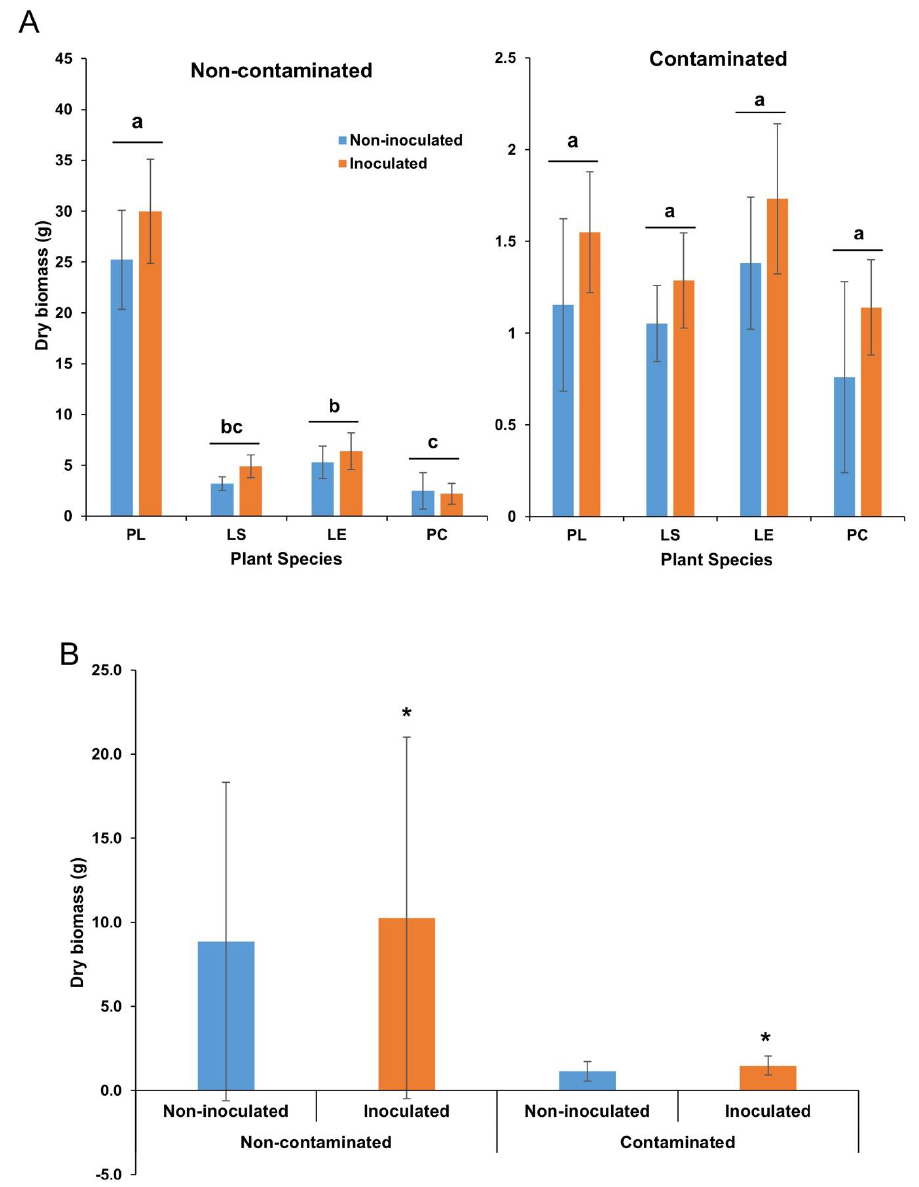
Figure 4. E ff ect of inoculation on average plant aerial dry biomass for each plant species ( A ) and overall ( B ), in the non-contaminated soil and the contaminated sediments. Errors bars are standard deviations. Within each contamination level, treatments not sharing the same letter are significantly di ff erent ( A ). Asterisks indicate a significant di ff erence between the two treatments in each contamination level ( B ). PL: Persicaria lapathifolia ; LS: Lythrum salicaria ; LE: Lycopus europaeus ; PC: Panicum capillare . N = 12 for each species.